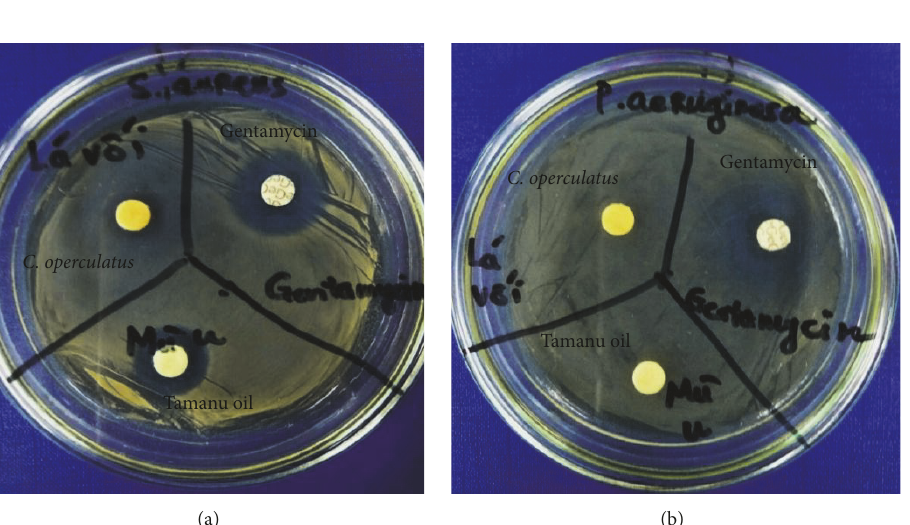
Figure 2: Antimicrobial activity of C. operculatus essential oil . Both CLO and commercial tamanu oil exhibited antibacterial activity against S. aureus whereas they did not inhibit the growth of P. aeruginosa . The diameter of inhibition zones against S. aureus of gentamicin (positive control) was highest ( 11.37±0.15 mm), followed by tamanu oil ( 9.03±0.31 mm) and CLO ( 7.17±0.12 mm). On the contrary, only gentamicin showed the antibacterial activity against P. aeruginosa ( 12.07±0.15 mm); both tamanu oil and CLO did not affect the growth of P. aeruginosa. This finding implies the potential use of CLO as anti-infective agent for burn wound treatment. The experiments were triplicated, and results were presented as mean ± standard